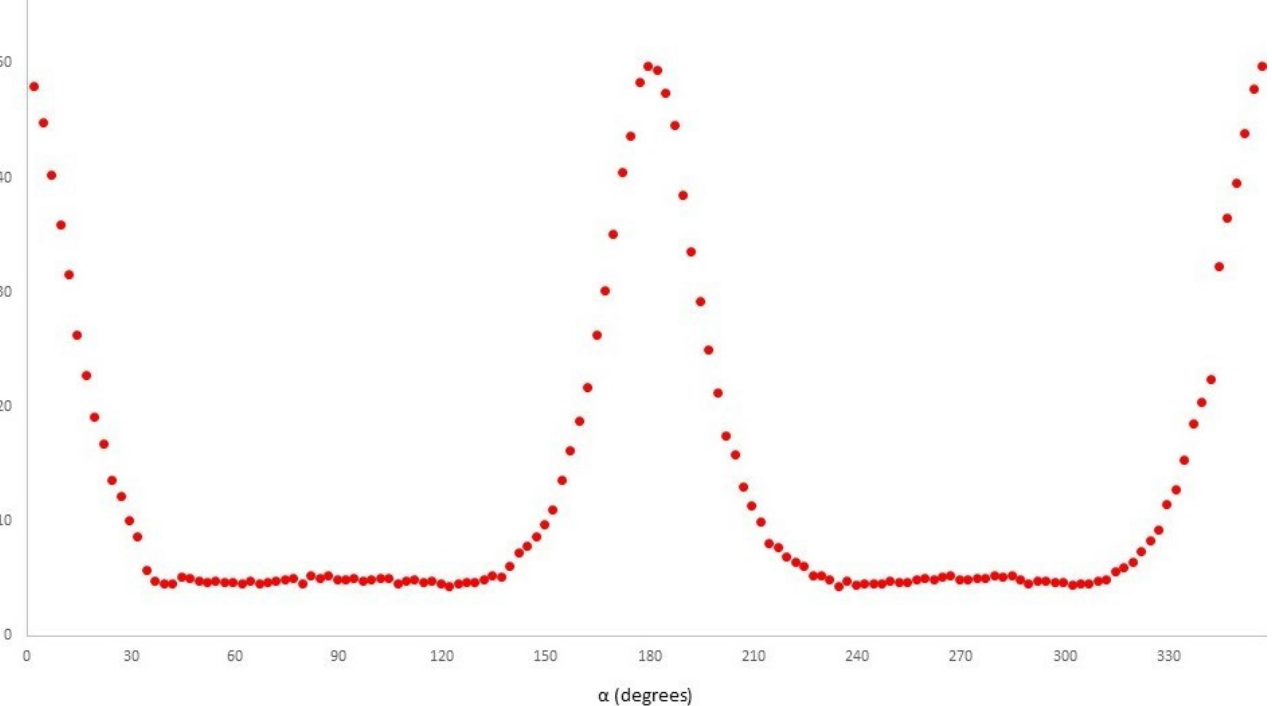
Figure 8. A plot of the azimuthal variation in the intensity in the SAXS patterns at the position of the lamellar stack scattering. Profile derived from the sixth pattern in Figure 6d, with an injection temperature of 190 °C.